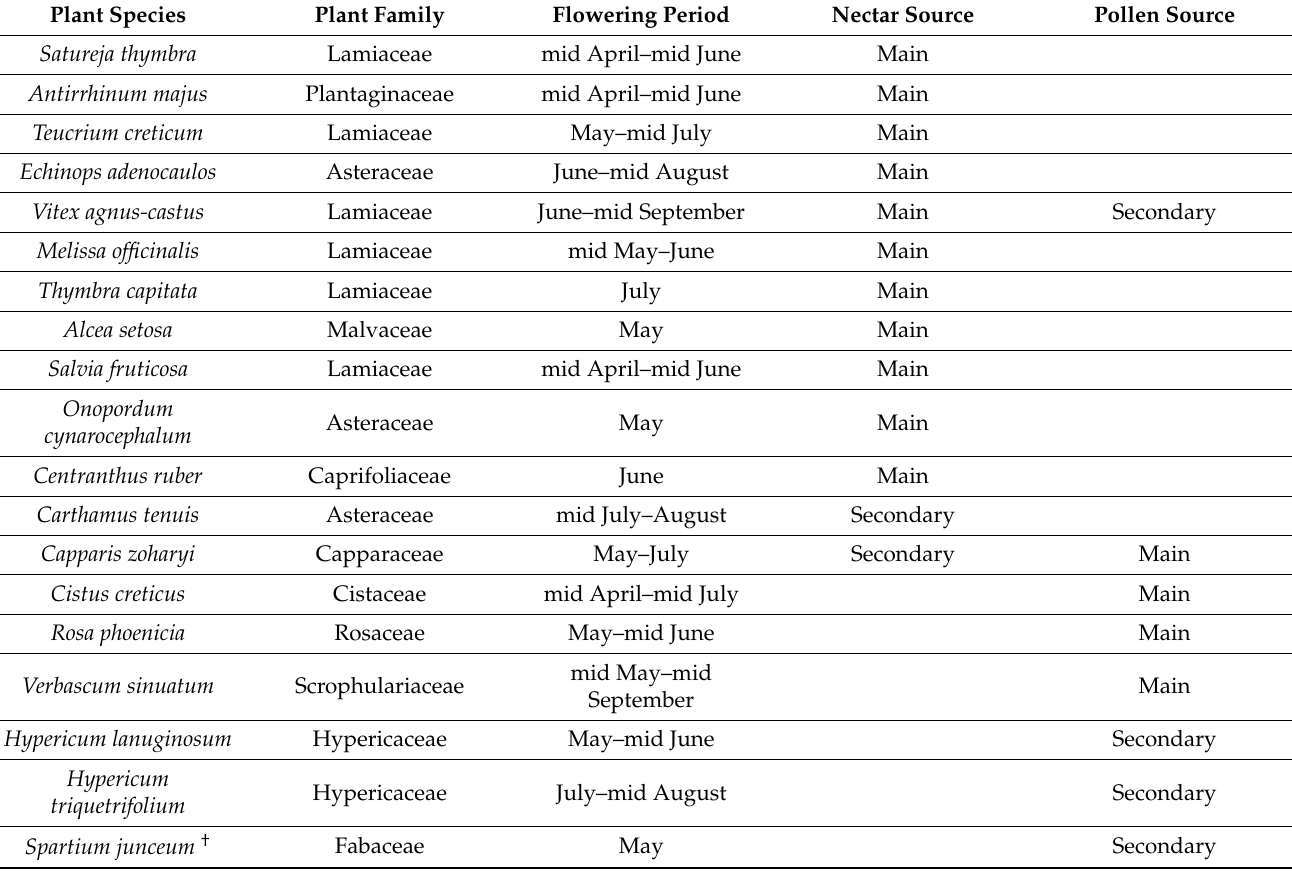
Figure 2. Mean number of visits per transect during four daily time points for bees classified into four categories during the peak season of 2012 (mid-May to mid-July) at the Soreq site. Bombus — Bombus terrestris ; Apis—Apis mellifera ; Xylocopa —various species of the genus Xylocopa (mostly X. violacea , and to lesser extent X. pubescens and X. iris ); wild bees—all other bees not included in the three categories mentioned above. Error bars indicate standard errors. Table 1. Plants visited by bumble bees in our study (flowering